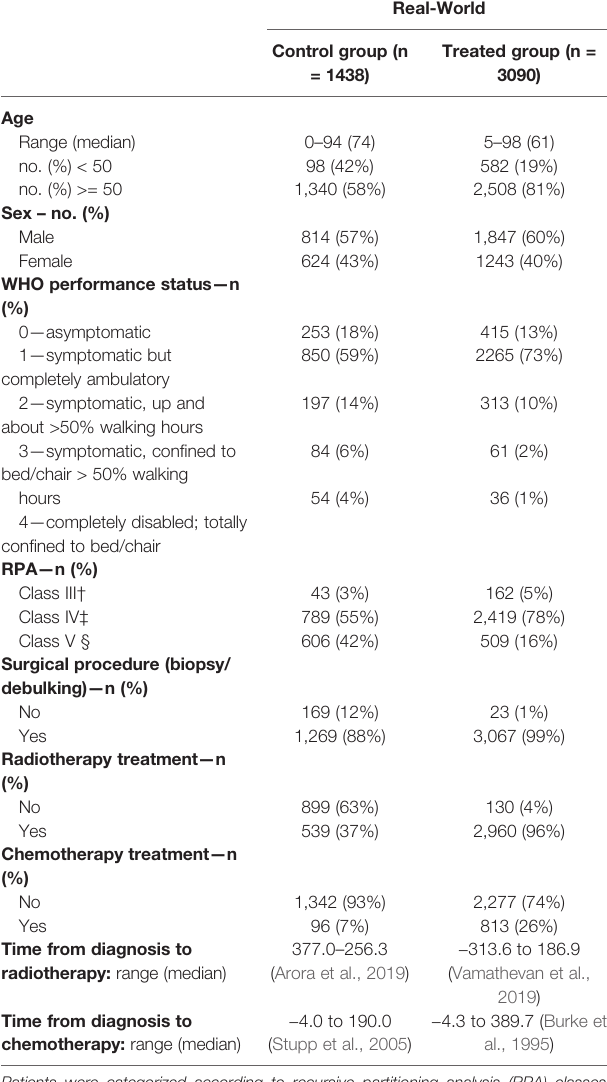
TABLE 1 | Main characteristics of the real-world study